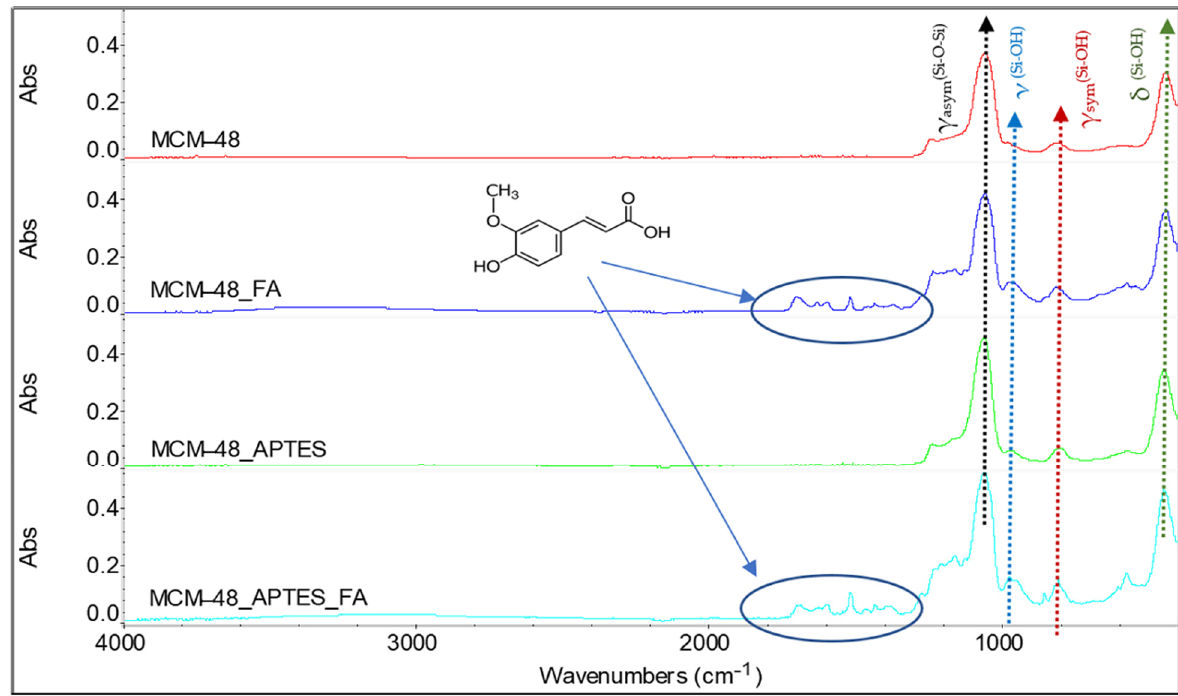
Figure 5. FTIR spectra and band assignments for the samples MCM-48, MCM-48_FA, MCM- 48_APTES and MCM-48_APTES_FA.